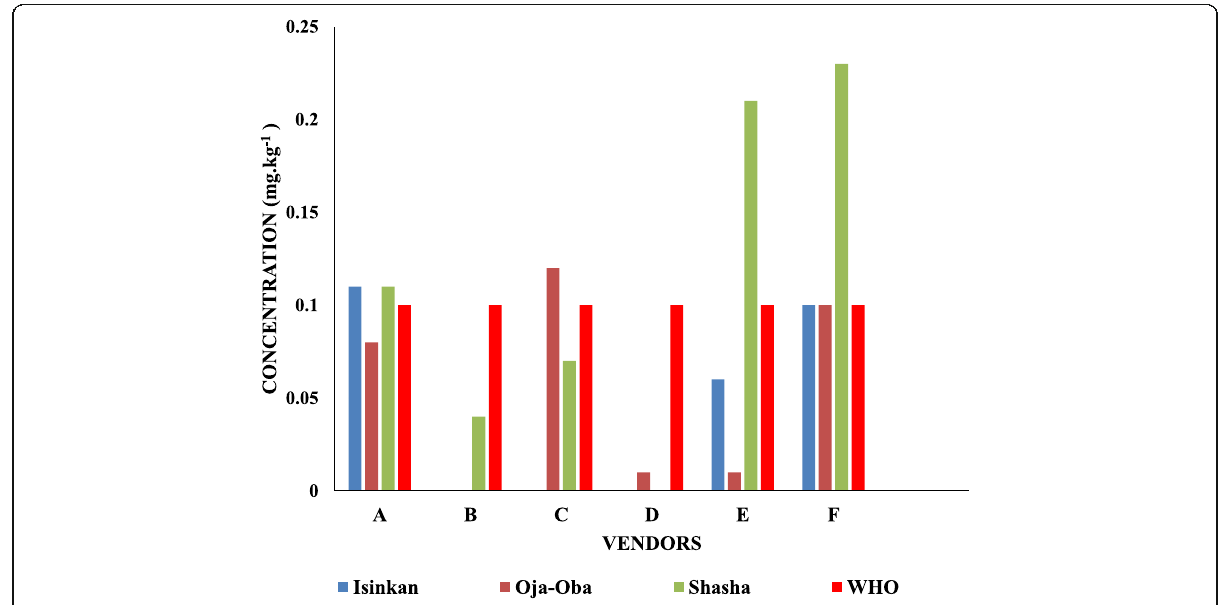
Fig. 4 Comparison of chromium concentrations in the sliced watermelon fruits with WHO permissible